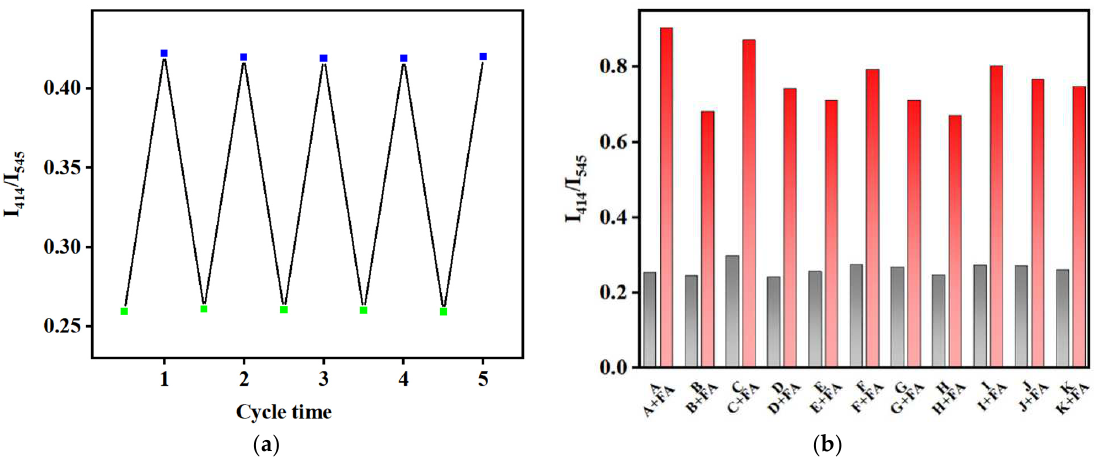
Figure 6. ( a ). Proportional fluorescence intensity of TH25 placed in DMF solution containing FA (blue, 500 ppm) and triethylamine (green, 500 ppm); ( b ). Interference of different substances with FA detection (fluorescence ratio measured at 414 nm and 545 nm of TH25 for FA (A) in presence of ZnO (B), CuSO 4 (C), D-glucose (D), Trypsin I, L-Histidine (F), L-Cysteine (G), L-Alanine (H), L-Glutamic (I), L-Sarcosine (J), Tyrosine (K)).